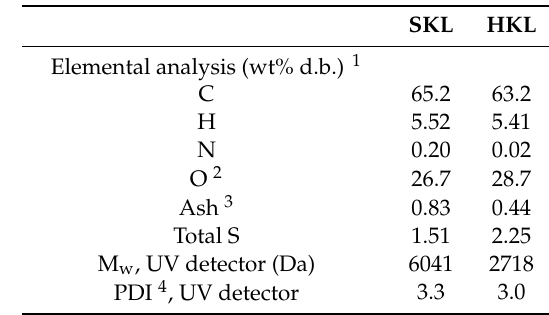
Table 5. Elemental analysis and the physical properties of softwood kraft lignin (SKL) and hardwood kraft lignin